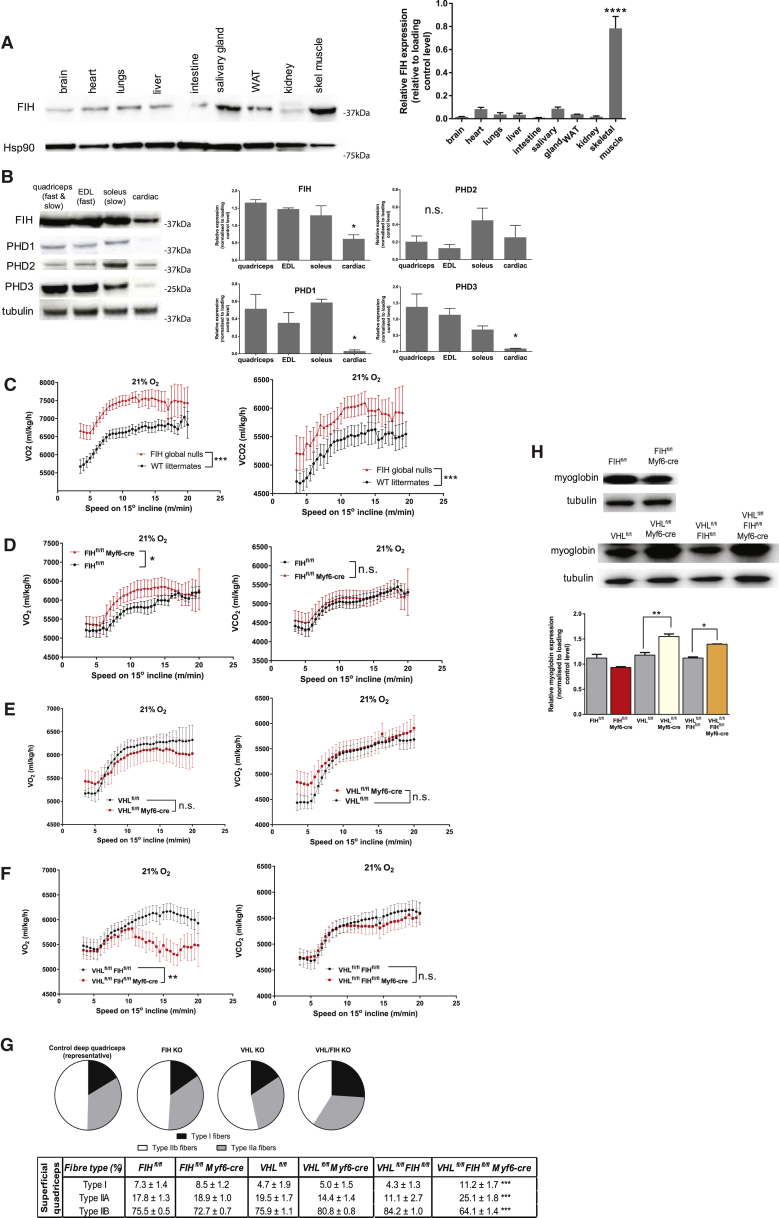
In Vivo Effects of FIH Loss in Mouse Skeletal Muscle Mirror Its Metabolic Roles in Cells(A) Representative immunoblot of FIH in whole organ lysates in a WT mouse, demonstrating different levels of FIH in different tissues.(B) Representative immunoblot of molecular oxygen sensors in whole muscle lysates taken from a WT mouse. Various hindlimb muscle samples were taken from male WT mice: the predominantly fast twitch extensor digitorum longus (EDL), predominantly slow twitch soleus, and quadriceps comprising both fast and slow twitch fibers. Cardiac muscle was sampled separately.(C) FIH nullizygous mice show increased oxygen consumption (VO2) and carbon dioxide production (VCO2) rates on an incremental uphill treadmill protocol.(D) VO2 and VCO2 measured during an incremental uphill exercise protocol in FIH skeletal muscle mutant versus control littermate mice over a range of exercise intensities, suggesting oxygen inefficiency. In contrast, the VCO2 curve was not significantly altered. A two-tailed Student's t test was applied to equations of curves fitted separately to control and mutant mice measurements.(E) vHL skeletal muscle mutant mice did not show the qualitative VO2 differences observed in FIH muscle-specific mutants.(F) vHL/FIH muscle double-KO mice show a fall-off in VO2 measurements at low exercise intensities. In contrast, their VCO2 is not altered.(G) Fiber type composition in cross-sections of frozen mouse superficial quadriceps from each genotype. Concurrent loss of FIH and vHL shifts fiber identity in deep quadriceps toward slow twitch, more oxidative fiber types. Six frozen sections were analyzed per mouse.(H) The loss of vHL leads to an increase in myoglobin expression in whole-quadriceps lysates of vHL KO muscle and vHL/FIH double KO, while the loss of FIH has no discernible effect.∗p < 0.05, ∗∗p < 0.01, ∗∗∗p < 0.001, ∗∗∗∗p < 0.0001; n.s., not significant. Data are represented as means ± SEM. Only male mice were used for in vivo experiments, with male littermates as controls. n = 7 mice/genotype, unless otherwise stated. For multiple comparisons (A, B, G, and H), a one-way ANOVA was used. For pairwise comparisons (C–F), a two-tailed Student's t test was used. After curve-fitting, best-fit equations were compared with an extra sum-of-squares F test. See also Figure S4.